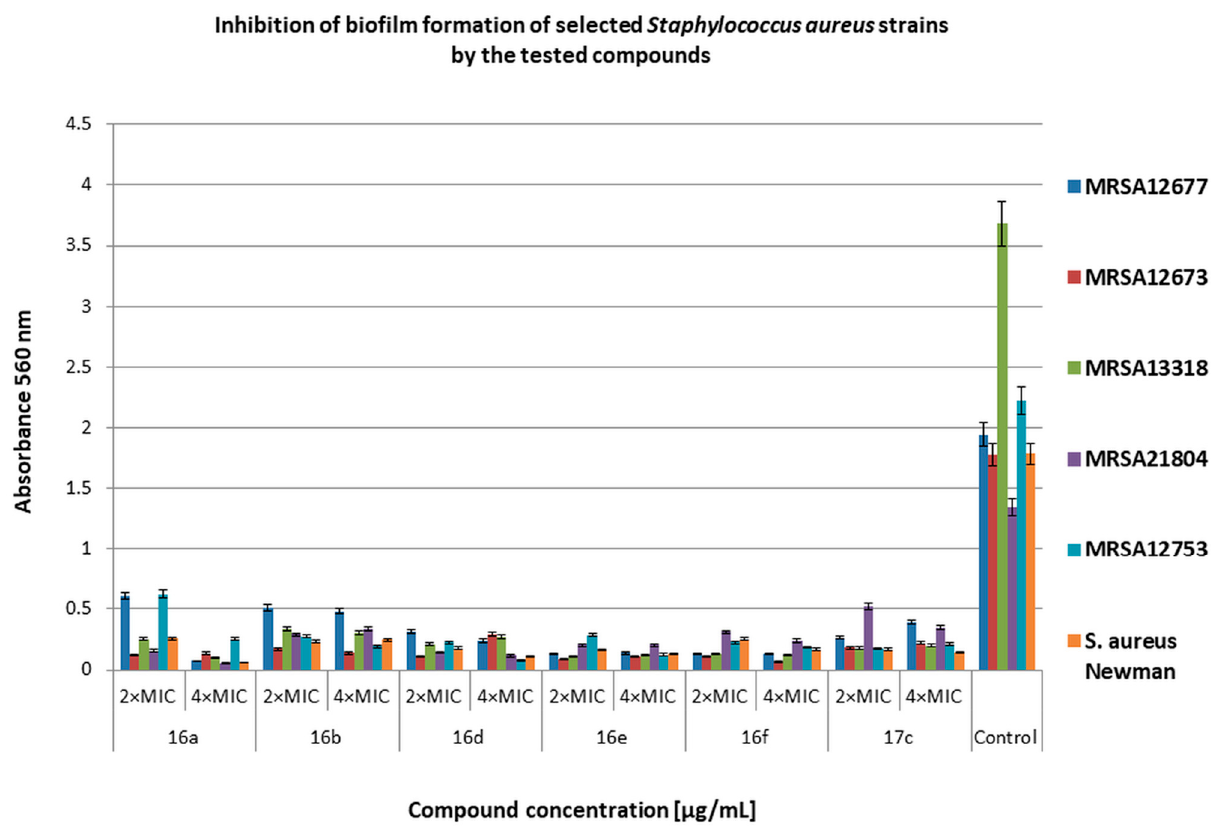
Figure 4. Inhibition of biofilm formation of selected methicillin-resistant Staphylococcus aureus (MRSA) strains by the tested compounds. Bacteria without compounds were a control group. Double the minimum inhibitory concentration—2 × MIC, quadruple the minimum inhibitory concentration—4 × MIC. The results are presented as mean values ± standard deviation (±SD) from three independent experiments. Error bars represent standard deviation.